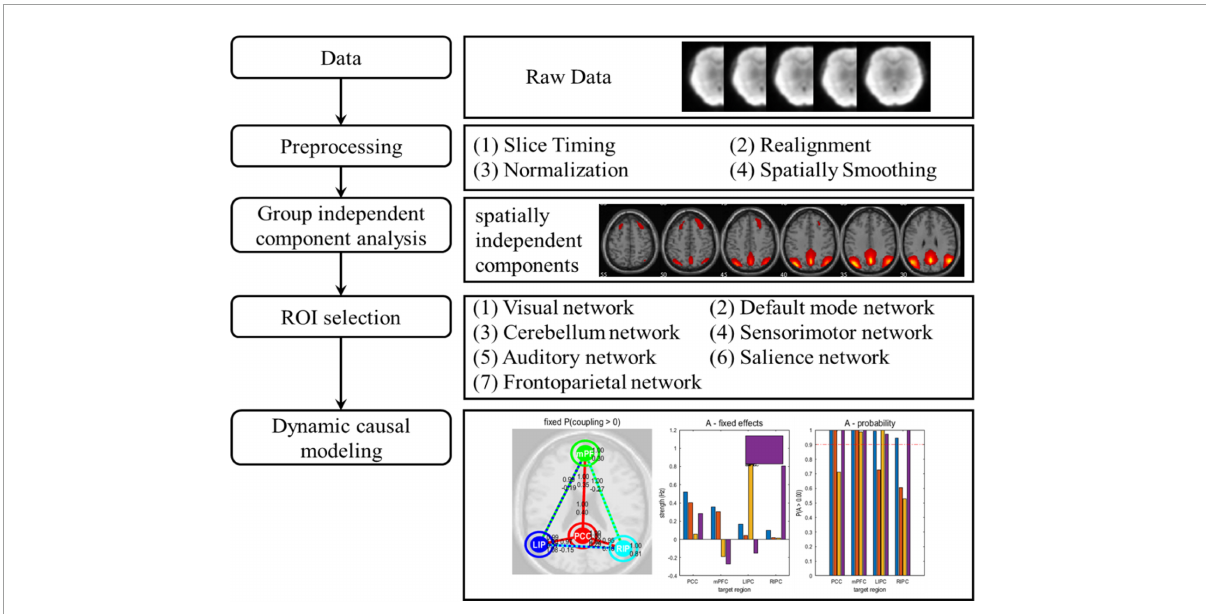
FIGURE1 The data analysis pipeline. After data acquisition and preprocessing, the data were divided into 7 different brain networks through group independent component analysis. For each brain network, selected the corresponding regions of interest. Finally, dynamic causal modelling of all brain networks was carried out.